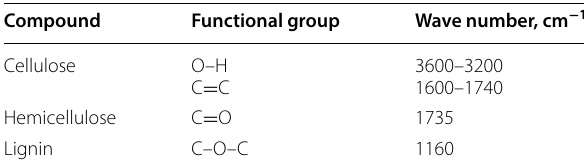
Table 6 Organic compounds and associated functional groups (Zhu et al. 2015; Liu and Han 2015; Zhao et